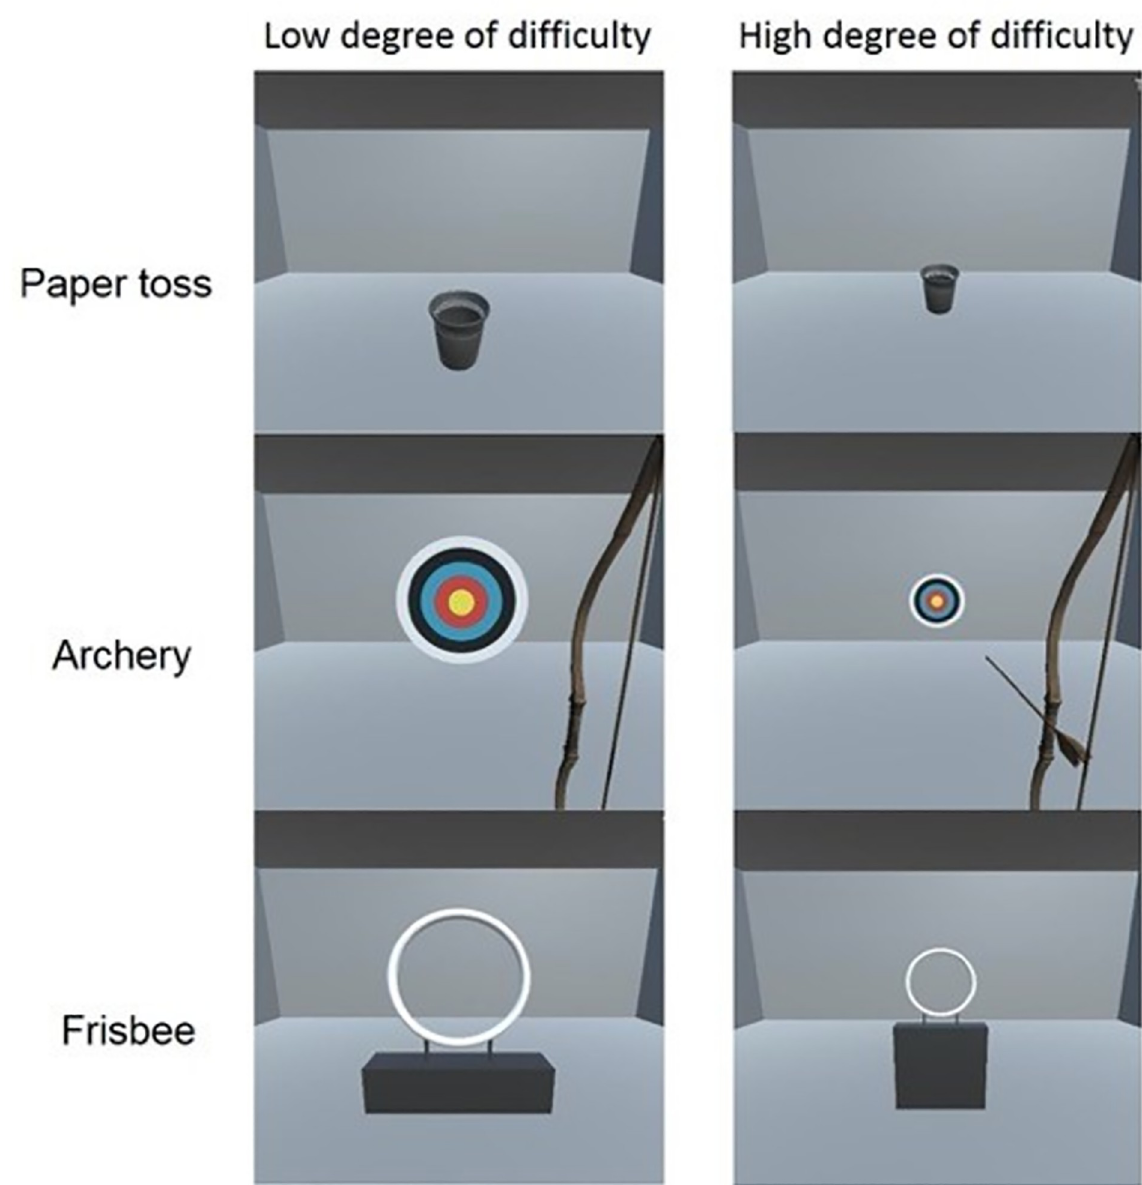
Fig 4. The 3 different BCI games for NF